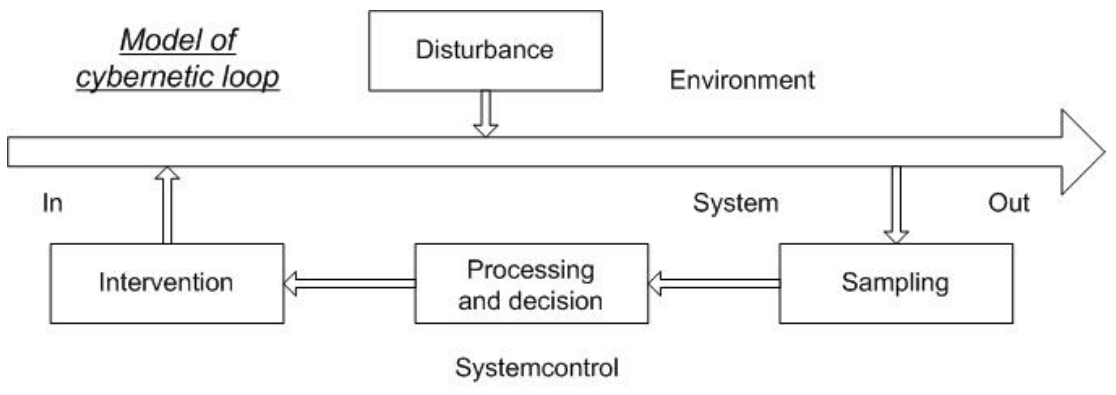
Figure 1. Simplified general model of cybernetic loop.